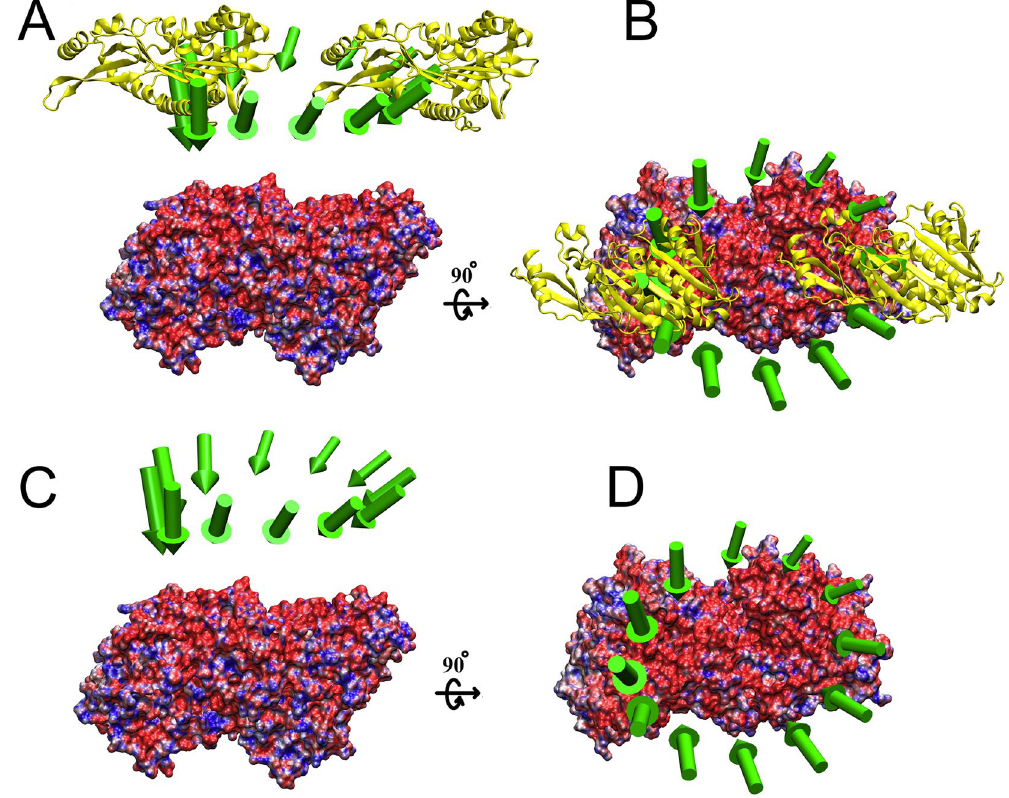
Figure 1. A funnel of electrostatic binding forces guides kinesin to the binding site on a tubulin dimer. The kinesin-13 structure (yellow) was shifted 20 Å away from its bound position and circled around the tubulin dimer (colored blue for positive surface charge and red for negative surface charge) along a circle with a radius of 40 Å. Every 30 degrees, the electrostatic force on the kinesin was calculated. These forces are represented by arrows (green) with their tail end located at the mass center of the kinesin in the 12 locations around the circle and their lengths proportional to the magnitude of the electrostatic force. ( A ) and ( C ) are the side views. ( B ) and ( D ) are the top views. In ( A ) and ( B ) the kinesin structure is shown at two positions for illustration of the range of displacement. In ( C ) and ( D ) the kinesin is hidden to provide clear view of the forces. In all frames, the total electrostatic forces were calculated using DelPhiForce and visualized with VMD 76